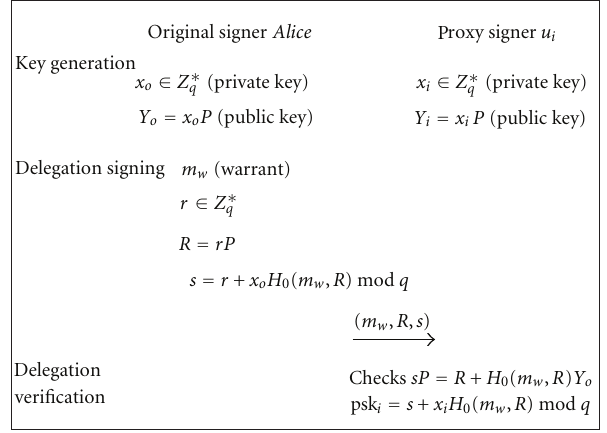
Figure 1: Key generation, delegation signing, and delegation verification phases of Yu et al.’s